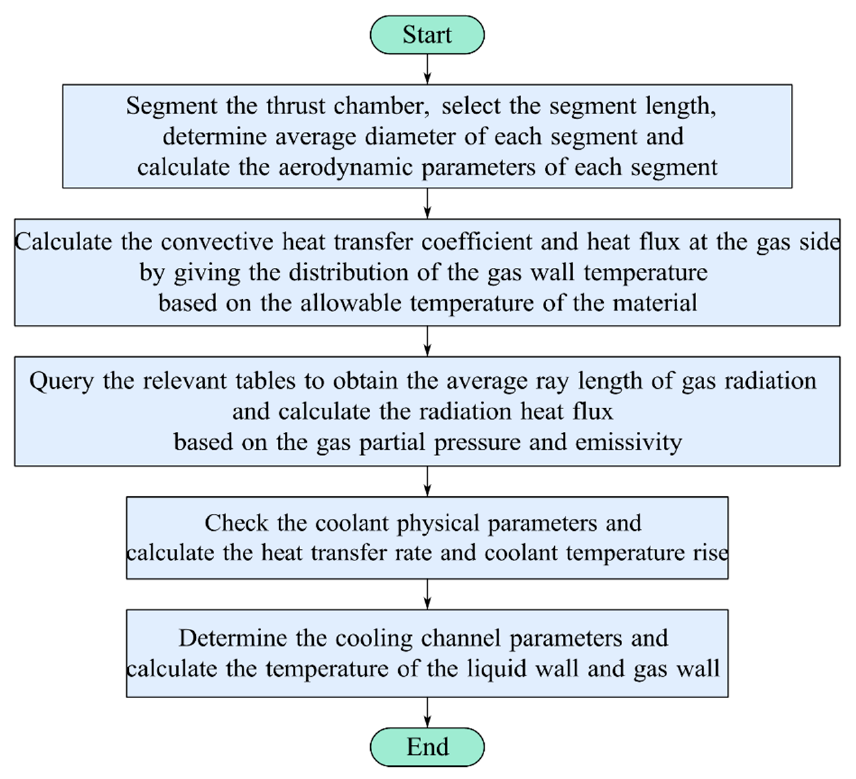
Figure 3. The one-dimensional preliminary calculation process for regenerative cooling.